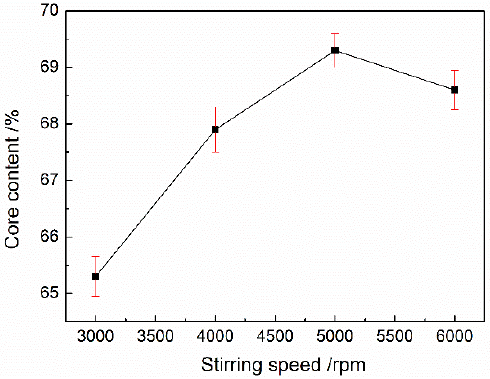
Figure 3. The influence of the stirring speed in emulsification on MicroPCMs’ core content.